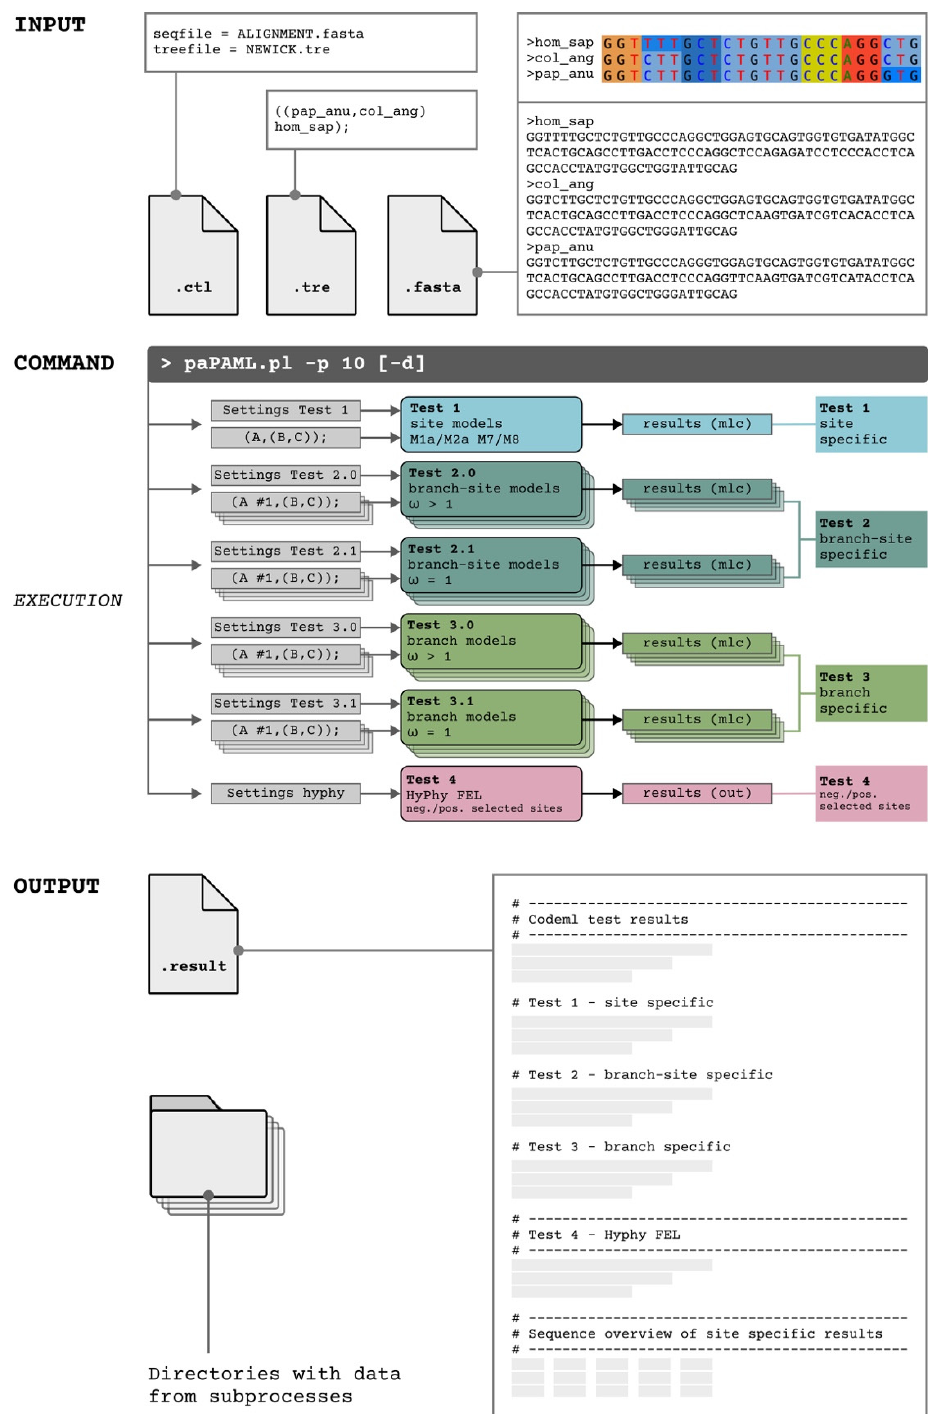
Figure 3. Input format, basic command-line options, and output of paPAML. The standard input of codeml and HyPhy is a fasta sequence file of aligned CDS excluding the stop codon, a Newick